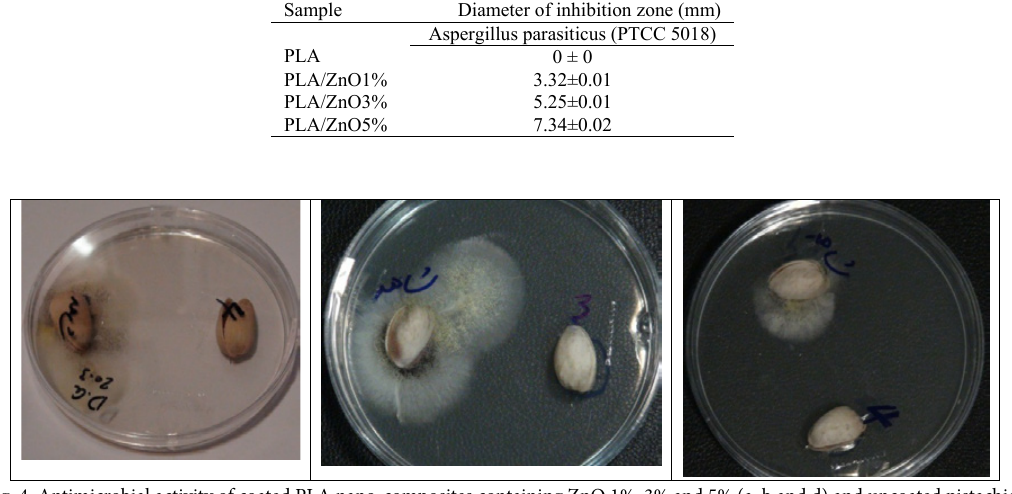
Fig. 4. Antimicrobial activity of coated PLA nano-composites containing ZnO 1%, 3% and 5% (a, b and d) and uncoated pistachios against Aspergillus flavus (PTCC 5004)